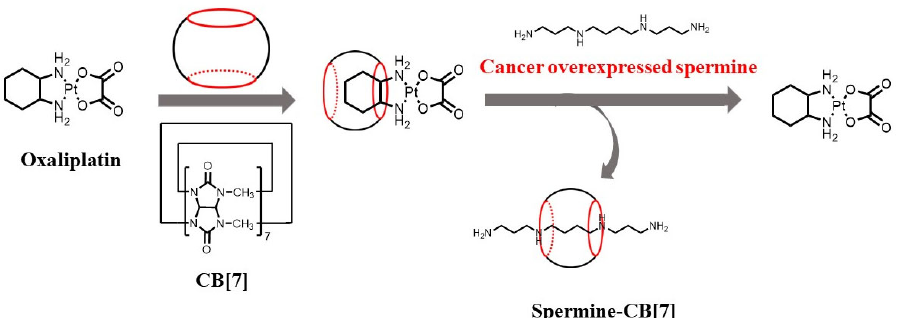
Figure 15. Supramolecular chemotherapy using oxaliplatin and CB[7] and its competitive release and replacement by spermine [86].